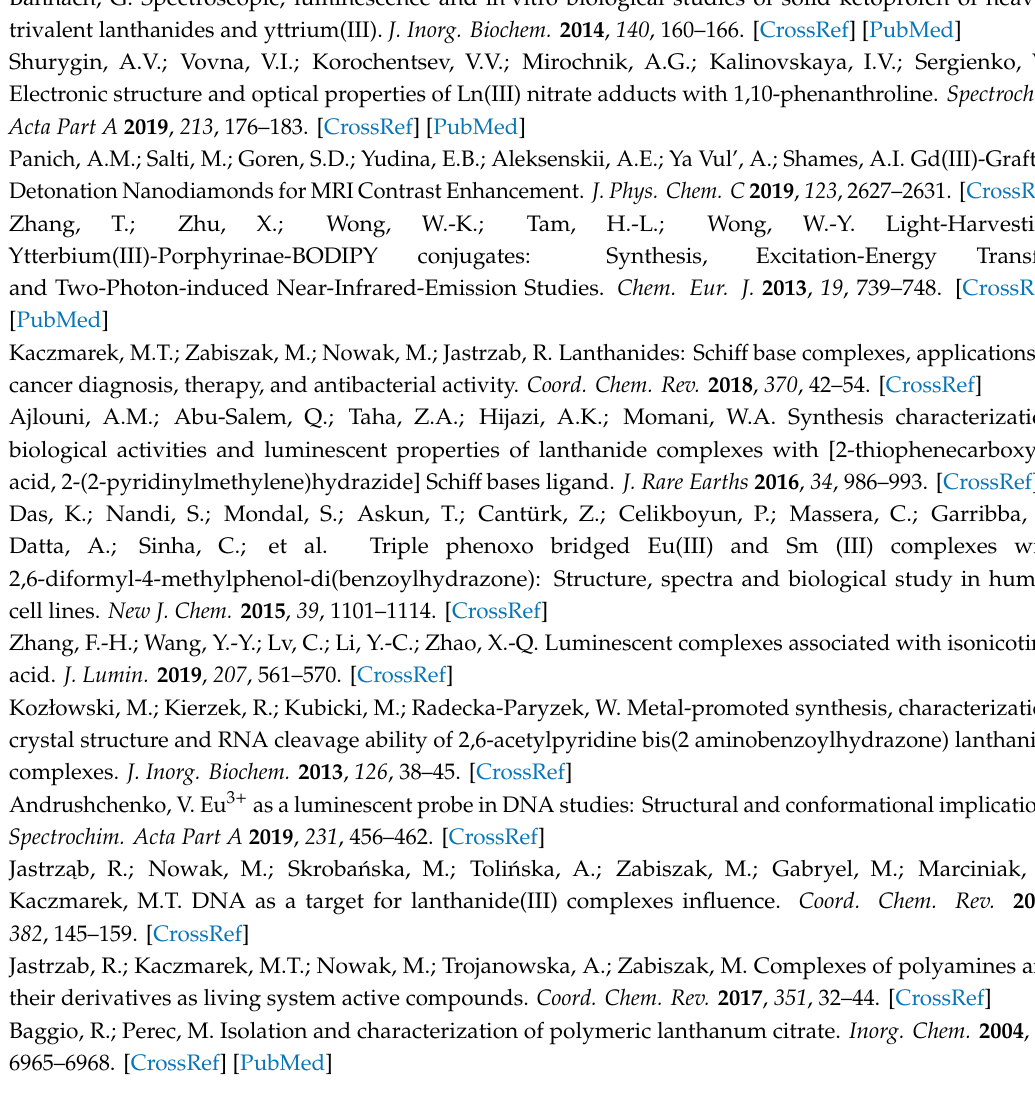
Figure S1: Distribution diagram of protonation forms of tartaric acid cTar = 1 × 10 − 3 mol dm-3, Figure S2: IR spectra of studied systems: a)La(III) / Tar; b) Gd(III) / Tar; c) Tb(III) / Tar; d) Ho(III) / Tar; e) Lu(III) / Tar, Figure S3: The CD spectra of the systems: (a) Nd / Tar; (b) Eu / Tar; (c) Gd / Tar; (d) Tb / Tar; (c) Lu /